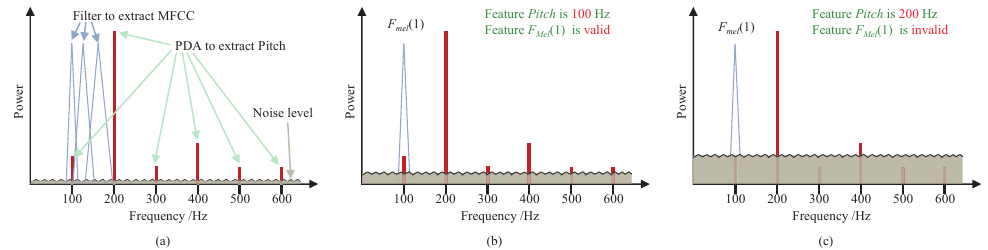
Figure 3. Noise influence on MFCC and pitch features. ( a ) Clean speech signal. ( b ) Speech signal with low level noise. ( c ) Speech signal with high level noise. PDA is the pitch estimation